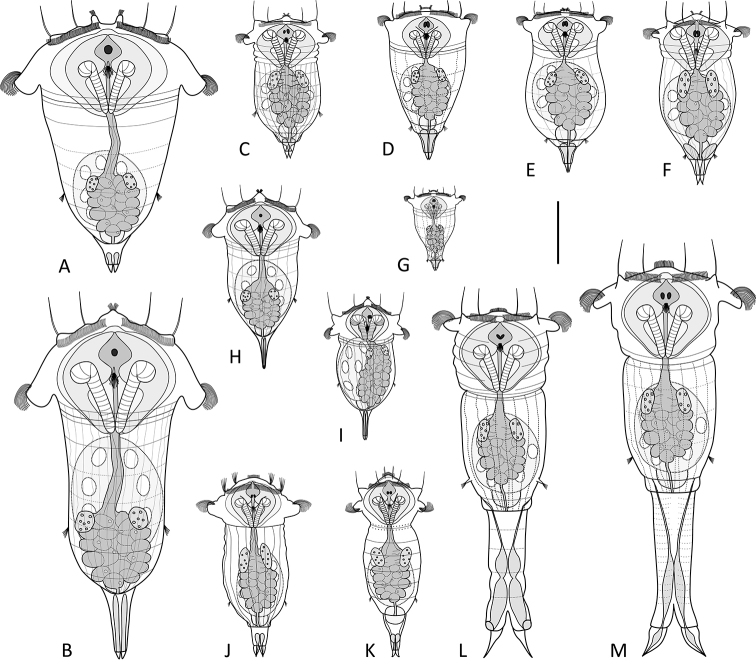
Species of Synchaeta from freshwater habitats. AS.
pectinataBS.
grandisCS.
oblongaDS.
tremulaES.
tremuloidaFS.
prominulaGS.
kitinaHS.
stylataIS.
longipesJS.
verrucosaKS.
lakowitzianaLS.
pachypoidaMS.
pachypoda. Drawings modified from: F, L, MKutikova and Vassiljeva (1982)JJersabek et al. (2003b)KLucks (1930). Scale bar: 100 µm.